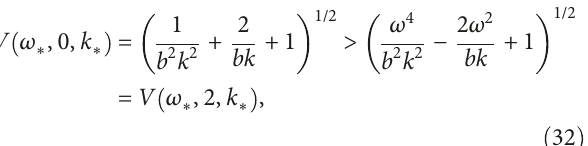
Figure 4: Diagram between V ω ω 2 2 ∗ / bk ∗ = 0 25